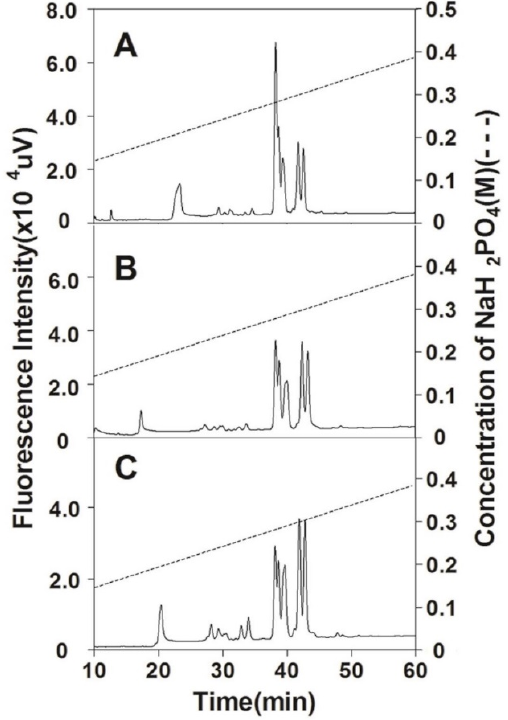
Figure 7. Analysis of tetrasaccharide fractions by anion-exchange HPLC. The tetrasaccharide fractions prepared from SHCS ( A ), SBCS ( B ), and SFCS ( C ) were analyzed by anion-exchange HPLC on a YMC-Pack PA-G column using a NaH 2 PO 4 gradient (indicated by the dashed line).